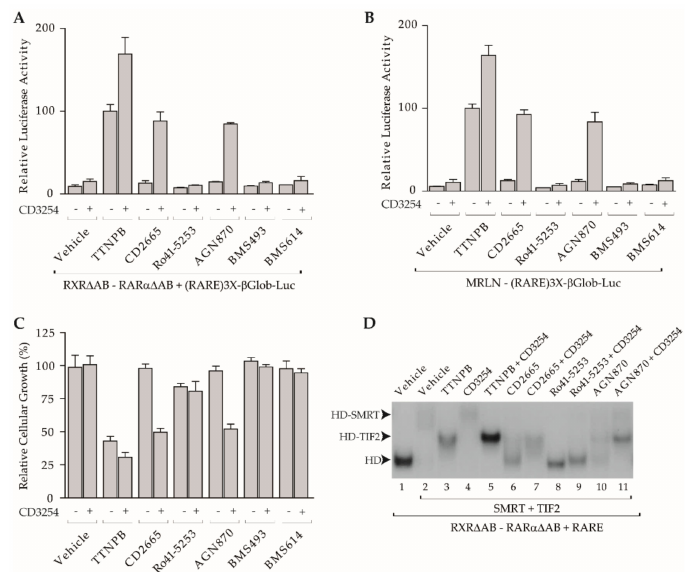
Figure 3. CD2665 and AGN870 synergize with CD3254 to activate RXR-RAR α -mediated pathways. In the following cellular assays, compounds were used at 1 µ M; ( A ) transient transactivation in COS cells co-transfected with the reporter (RARE)3x-tk-Luc and RAR α ∆ AB and RXR ∆ AB expression vectors in the absence or in the presence of indicated retinoids used alone or combined with CD3254 reveals synergy between CD3254 and CD2665 or AGN870 (100%, TTNPB induced activity). Error bars, s.e.m.; ( B ) transactivation assays in MRLN cells stably transfected with the reporter (RARE)3x-tk-Luc in the absence or in the presence of indicated retinoids used alone or with CD3254 reveals synergy between CD3254 and CD2665 or AGN870 through endogenous RXR-RAR α (100%, TTNPB induced activity). Error bars, s.e.m.; ( C ) e ff ects of indicated retinoids used alone or with CD3254 on anchorage-dependent growth of MCF-7 mammary carcinoma cells in culture after six days compared to the non-treated control (100%).Error bars, s.e.m., ( D ) EMSAs demonstrating ligand-dependent co-regulator recruitment by the RAR α ∆ AB- RXR ∆ AB heterodimer (HD). RARE oligonucleotide, HD, SMRT, and TIF2 were co-incubated in the absence or in the presence of saturated amounts of indicated retinoids used alone or with